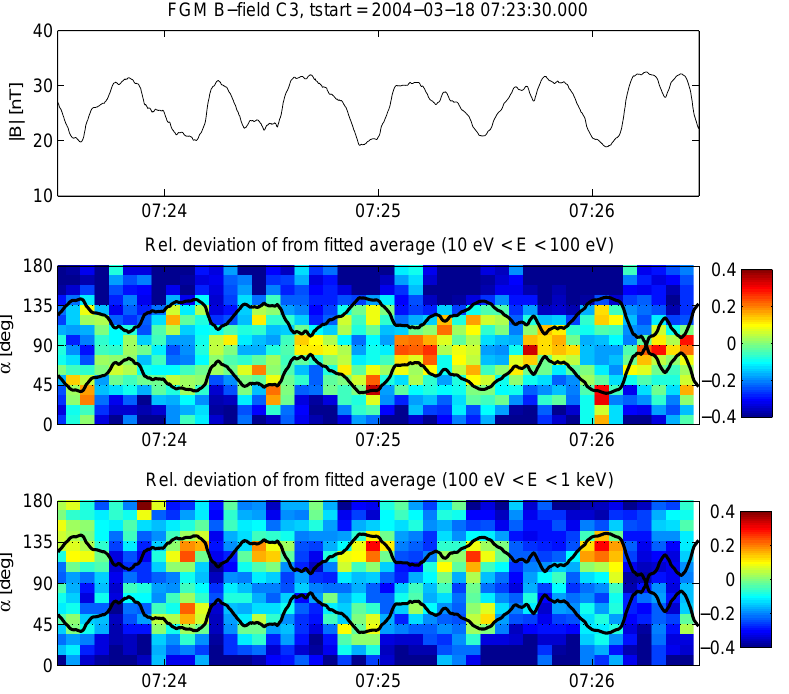
Fig. 8. Pitch angle distribution spectrograms integrated in low (middle panel) and high energy bands (bottom panel). Distributions are plotted as relative deviation of measured integrated 2-D distribution from the fitted background f Af (linear color scale).